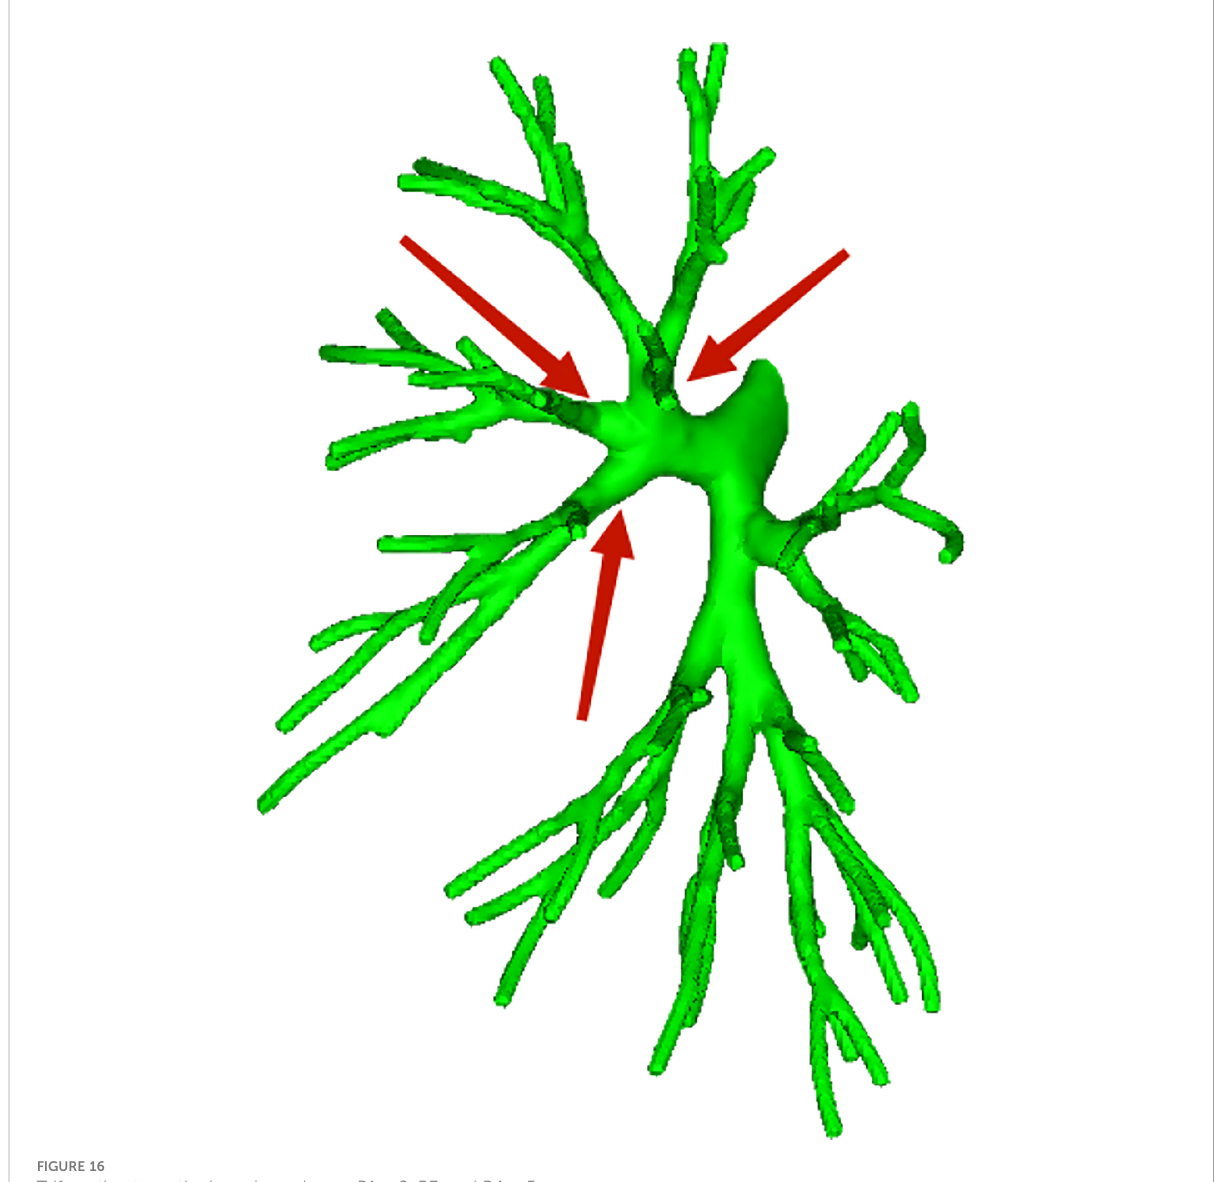
FIGURE 16 Trifurcation type; the branch mode was B1 + 2, B3, and B4 +